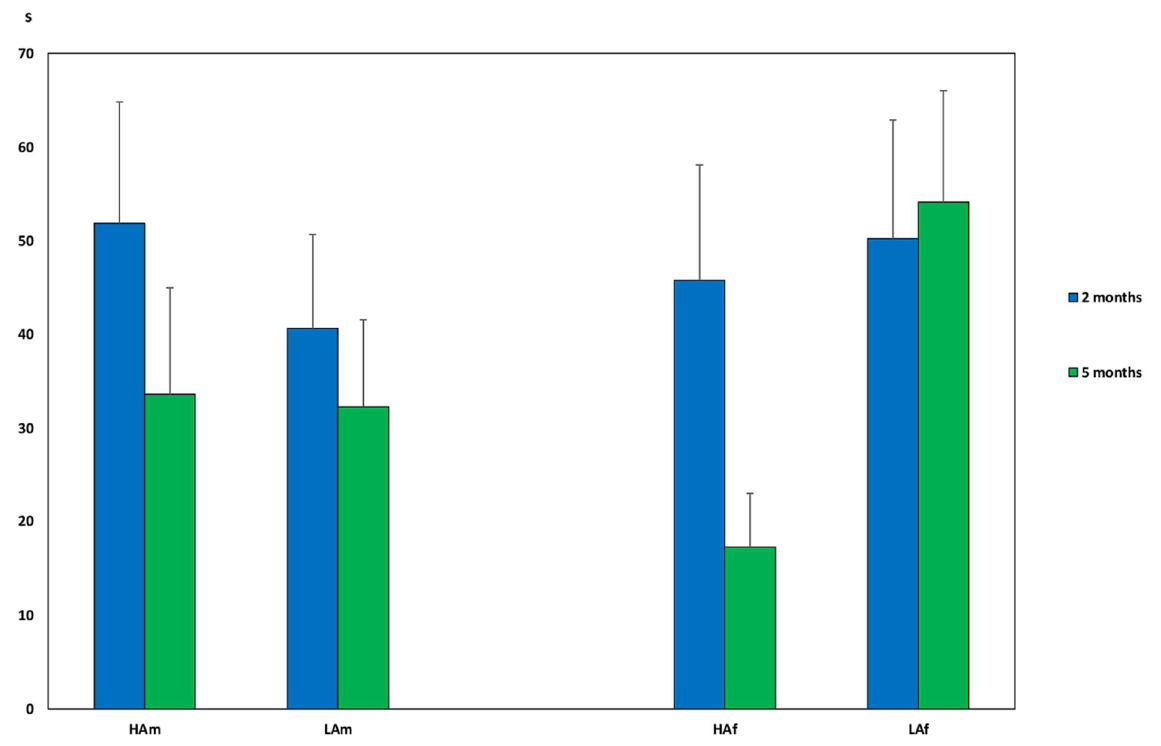
Figure 5. Time spent on the elevated plus maze open arms .